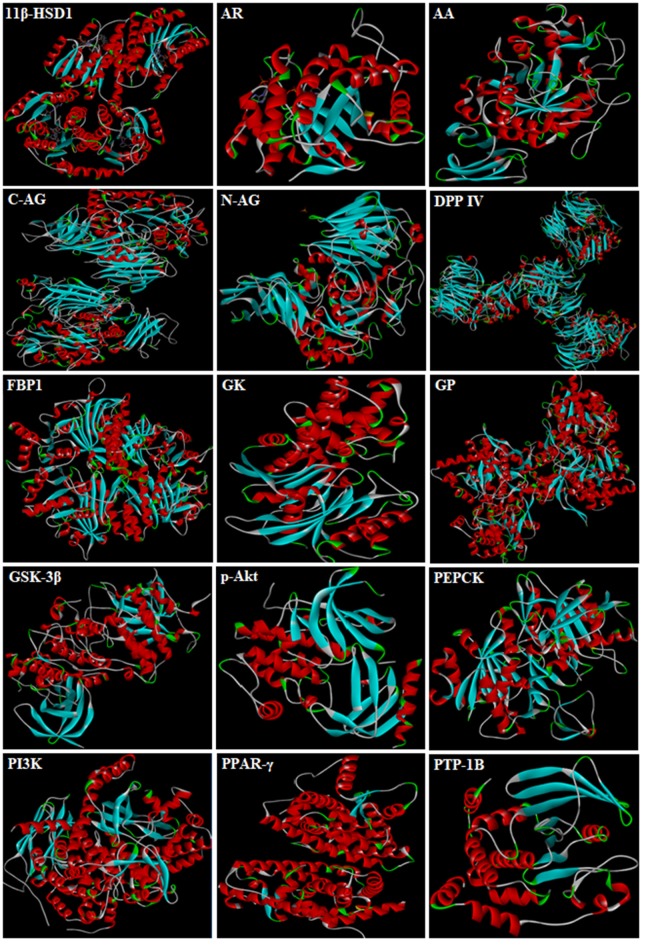
3D-structures of protein targets involved in diabetes: alpha amylase (AA), C-alpha glucosidase (C-AG), N-alpha glucosidase (N-AG), aldose reductase (AR), glucokinase (GK), glycogen phosphorylase (GP), fructose-1,6-bisphosphatase (FBP1), phosphoenolpyruvate carboxykinase (PEPCK), 11β-hydroxysteroid dehydrogenase-1 (11β-HSD1), glycogen synthase kinase-3β (GSK-3β), peroxisome proliferator-activated receptor γ (PPAR-γ), phosphatidylinositol 3 kinase (PI3K), phosphorylated-Akt (p-Akt), dipeptidyl peptidase-IV (DPP IV) and protein tyrosine phosphatase 1B (PTP-1B).